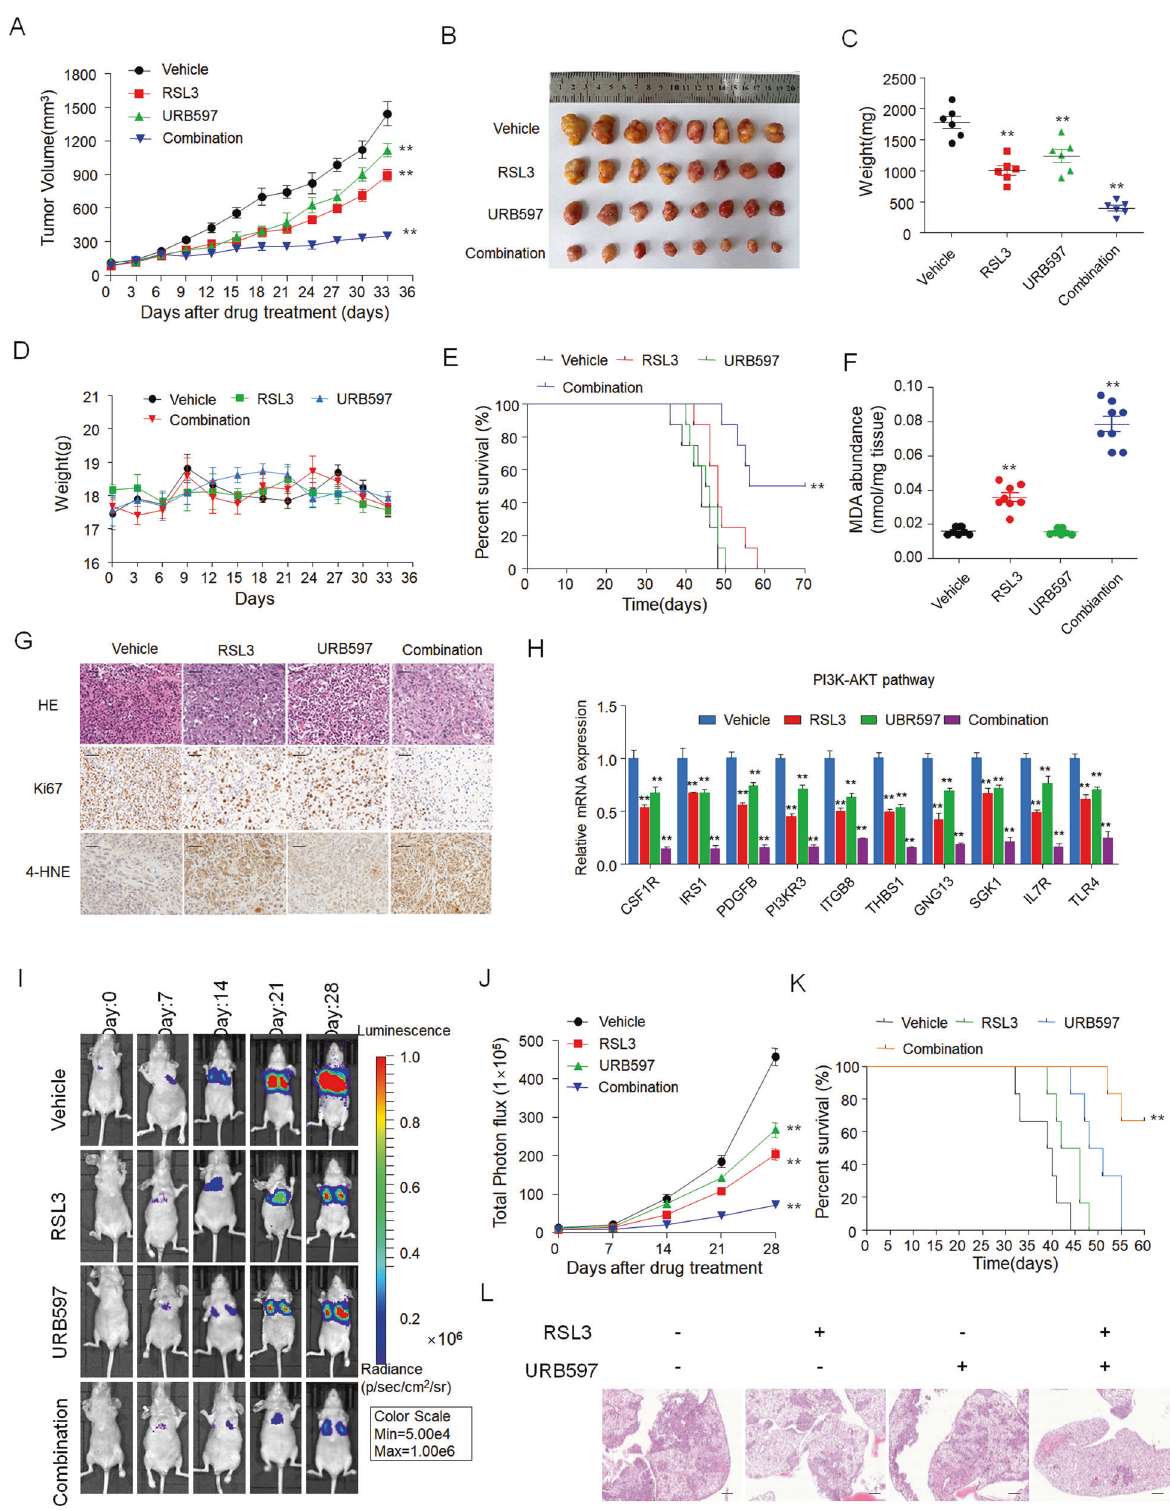
(Fig. 7H), which was consistent with in vitro experiments. To assess the impact of combinational treatment on experi- mental metastasis, athymic nude mice were given intravenous